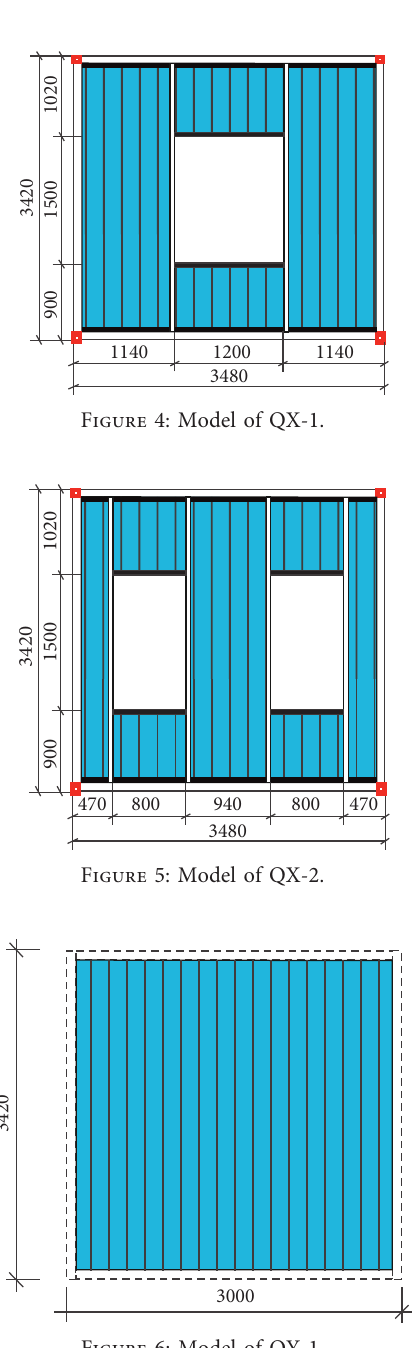
Figure 6: Model of QY-1.